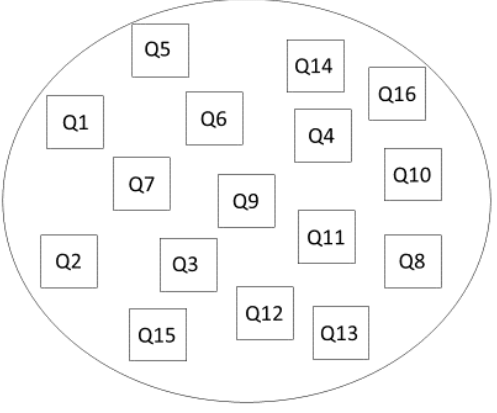
Figure 3. The position of 10 × 10 cm quadrats in the CO 2 ring injection of the FACE system. Total number of algal cells in a mL = number of cells counted/10 µ L × 1.0 × 10 4